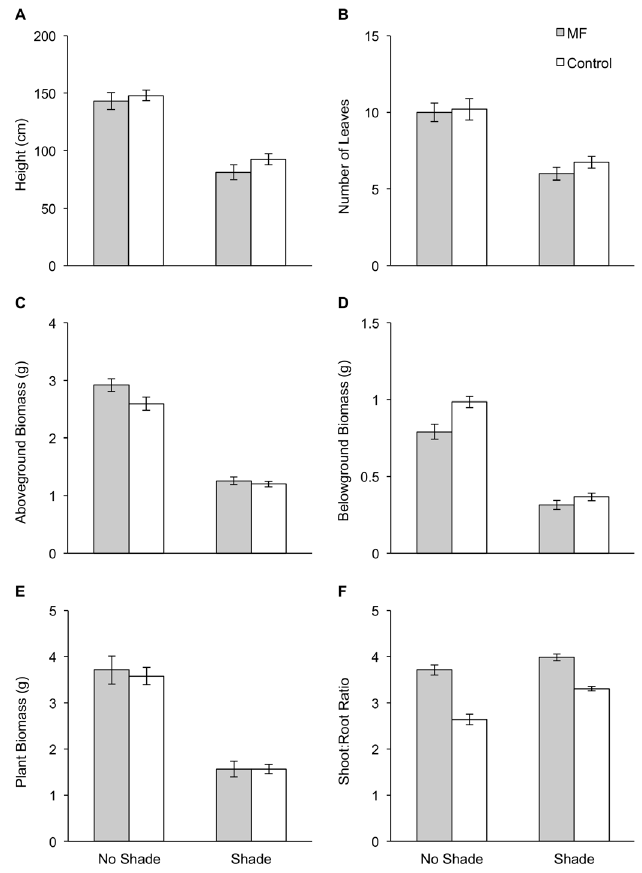
Fig. 2: Effects of mycorrhizal fungi and light availability on vegetative plant and biomass traits. Plant height (a) and number of leaves per plant (b) were determined at the end of the cultivation period. Total plant aboveground biomass (c), belowground biomass (d), total biomass (e) and plant shoot:root ratio (f) were determined on dry weight basis. MF = Mycorrhizal Fungi; Values shown are means + SE; n = 15 plants per